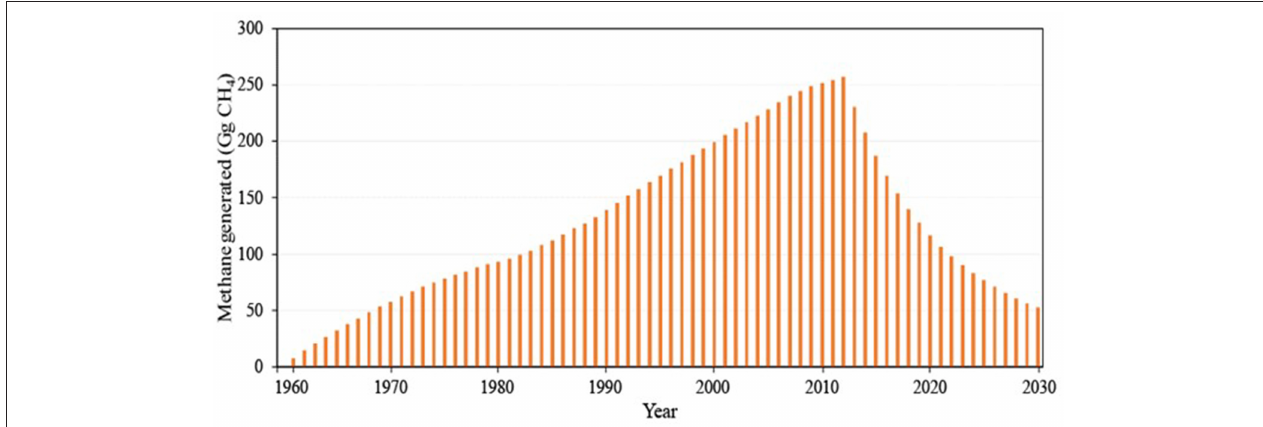
FIGURE 2 | Methane emissions from deposited waste in BP landfill. The trend of methane emissions from deposited waste in Bordo Poniente landfill during the period 1960–2030 figure shows an increasing trend from 1960 to 2011 and a decreasing trend for the remaining years. It should be noted that Bordo Poniente landfill has been closed in 2011. From 2012, Bordo Poniente plant only receives organic waste for composting.